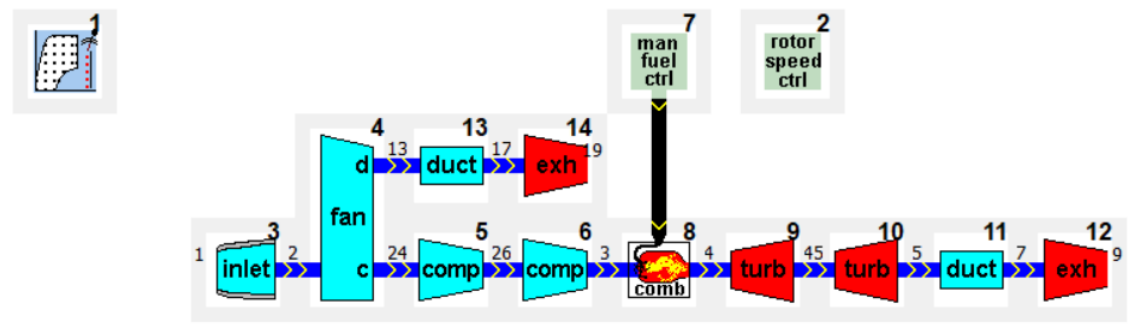
Figure 1. Configuration of high bypass turbofan engine modelled in GSP. Station 4 (Fan), Station 5 (LPC), Station 6 (HPC), Station 8 (CC), Station 9 (HPT) and Station 10 (LPT). Table 3. Engine characteristics adapted from Gaspar and Sousa [29].